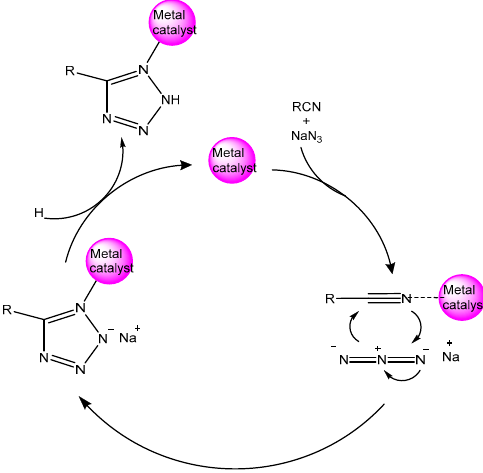
Figure 8. Plausible reaction mechanism for tetrazole synthesis [100].